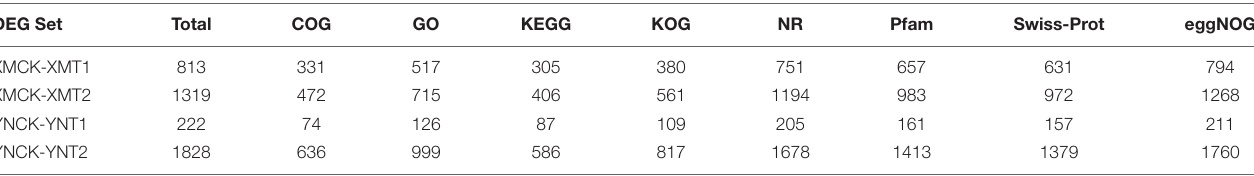
FIGURE 3 | (A) The number of DEGs in each comparison group, (B) The number of upregulated and downregulated DEGs in each comparison group, (C) Venn diagram of upregulated DEGs in each comparison group, and (D) Venn diagram of downregulated DEGs in each comparison group. XMCK, Xinmai26 was treated at 16 ◦ C; XMT1, Xinmai26 was treated at 4 ◦ C for 4 h; XMT2, Xinmai26 was treated at − 4 ◦ C for 4 h; YNCK, Yannong19 was treated at 16 ◦ C; YNT1, Yannong19 was treated at 4 ◦ C for 4 h; YNT2, Yannong19 was treated at − 4 ◦ C for 4 h. TABLE 3 | Summary of differentially expressed genes (DEGs) in different